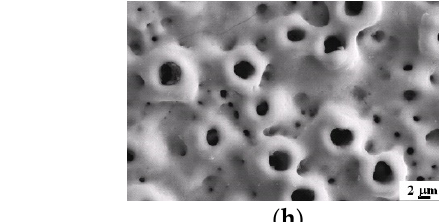
Figure 2. SEM images of the MAO coatings produced in solutions with different Na 2 MgY and KOH concentrations: ( a ) the Mg-5 system, ( b ) Mg-10 system, ( c ) Mg-15 system, ( d ) Mg-20 system, ( e ) Mg-10-KOH-2 system, ( f ) Mg-10-KOH-5 system, ( g ) Mg-10-KOH-8 system and ( h ) Mg-10-KOH-11 system. The samples fabricated in the solutions containing 15-g/L H 12 Phy and different Na 2 MgY concentrations were mainly composed of anatase, rutile, MgO and Mg 3 (PO 4 ) 2 phases (Figure 3a). With increasing Na 2 MgY concentrations from 5 to 20 g/L, the char- acteristic peak of the Mg 3 (PO 4 ) 2 phase at (100) increased in intensity and exhibited the maximum intensity for the Mg-20 system.